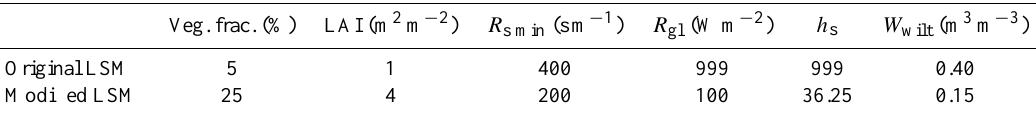
Table 2. Land surface model parameters used for simulations in the Houston metropolitan area. Vegetation fraction represents “green vegetation fraction” in